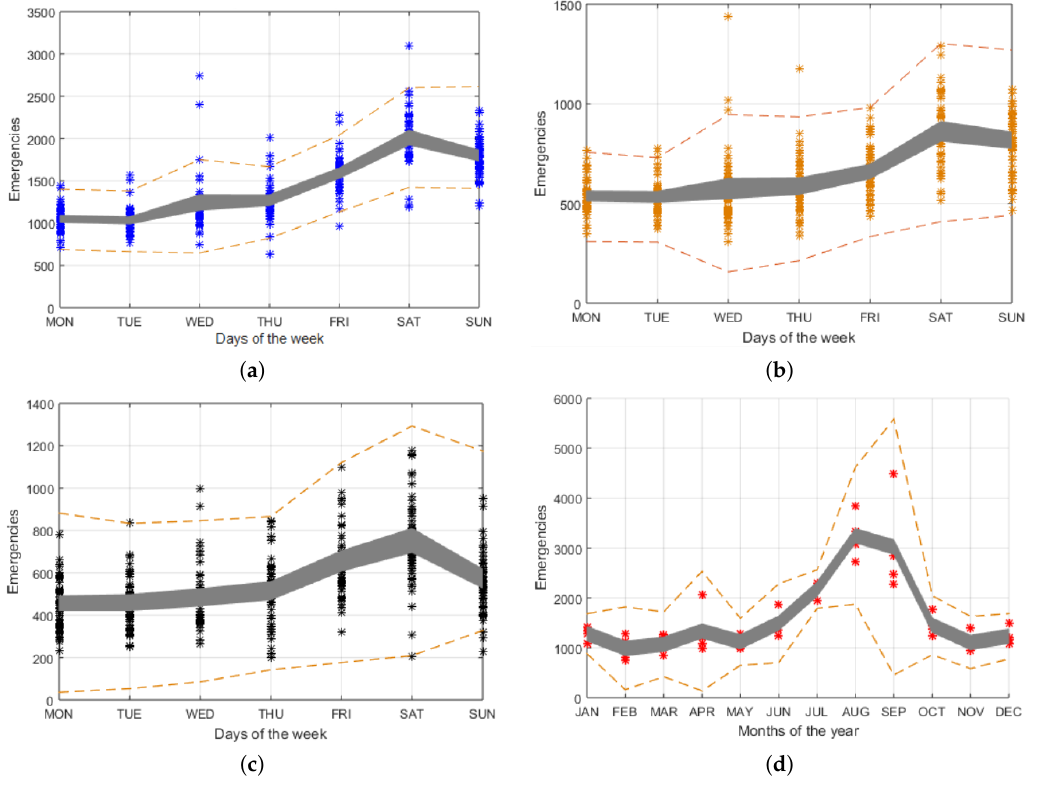
Figure 7. Temporal representation of the confidence interval (CI) of events during 2014, for police ( a ); health ( b ); and transit ( c ) services; as well as fire brigade events over 4 years, from 2013 to 2016 ( d ). Dashed lines are the criterion used to identify the OE, and gray areas are used to characterize the repeating patterns and subsequent resource allocation by